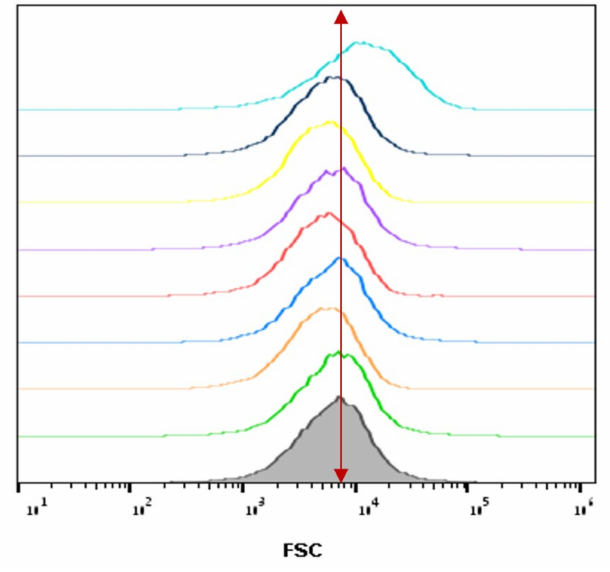
Figure 5. Relative bacterial cell size analysis of A. tumefaciens , plasma-treated for 45 s, and nontreated, at selected times (0, 2, 4, and 24 h.). Unstained cells: gray. Nontreated and plasma-treated bacteria at time zero: green and orange, respectively. Nontreated and plasma-treated bacteria at 2 h: azure and red, respectively. Nontreated and plasma-treated bacteria at 4 h: purple and yellow, respectively. Nontreated and plasma-treated bacteria at 24 h: turquoise and light blue,